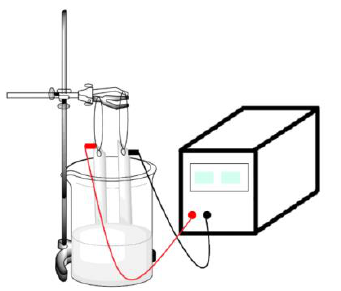
Figure 1. Scheme of electrocoagulation batch reactor (DC power and reactor with